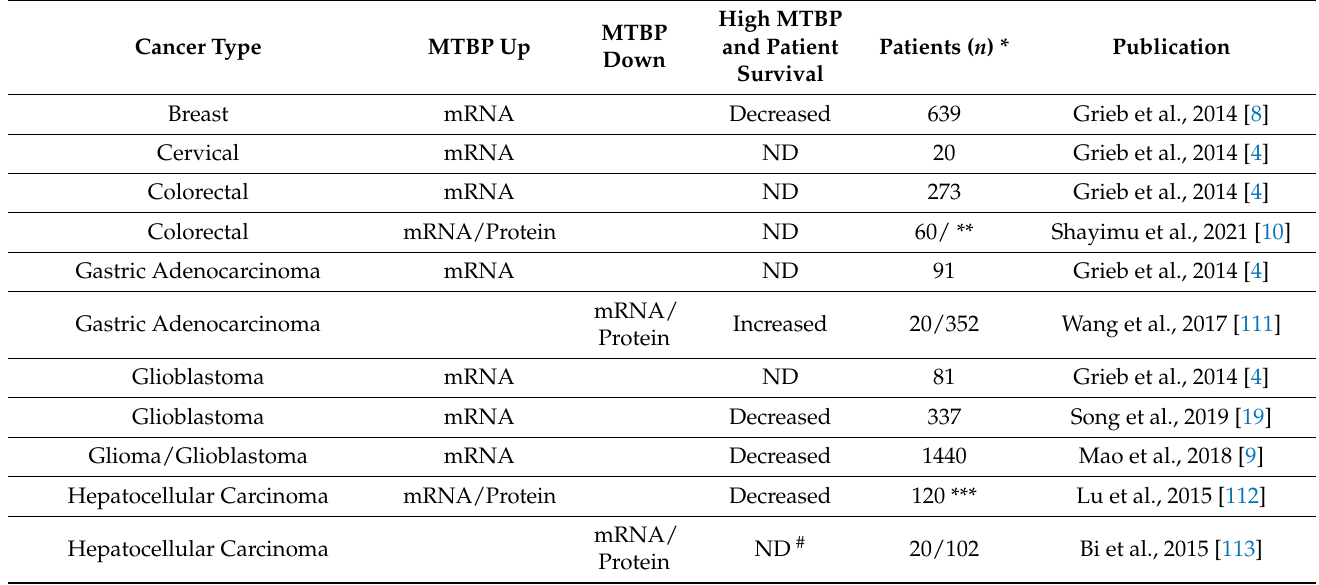
Table 1. Expression of MTBP mRNA or protein in human cancers and correlation with patient overall